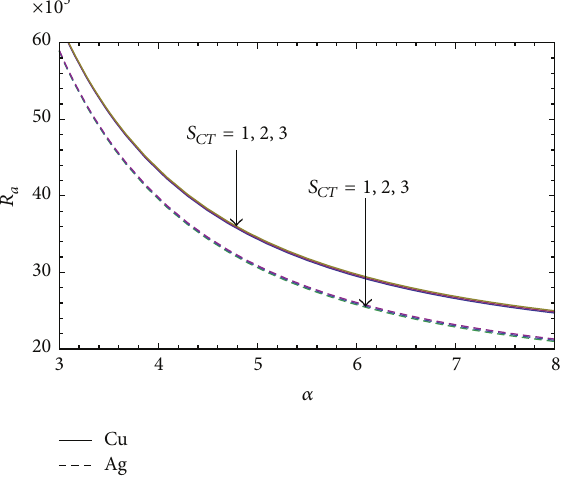
Figure 11: Effect of 𝑆 𝐶𝑇 on metallic nanoparticles.